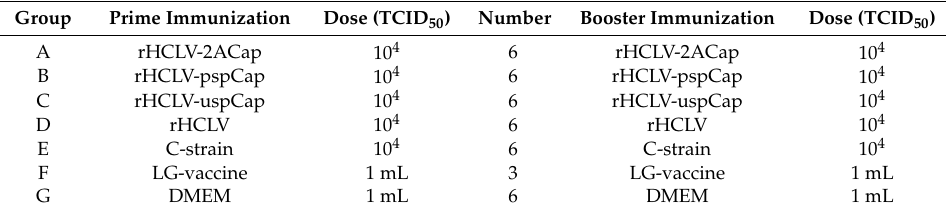
Table 2. The animal experiment